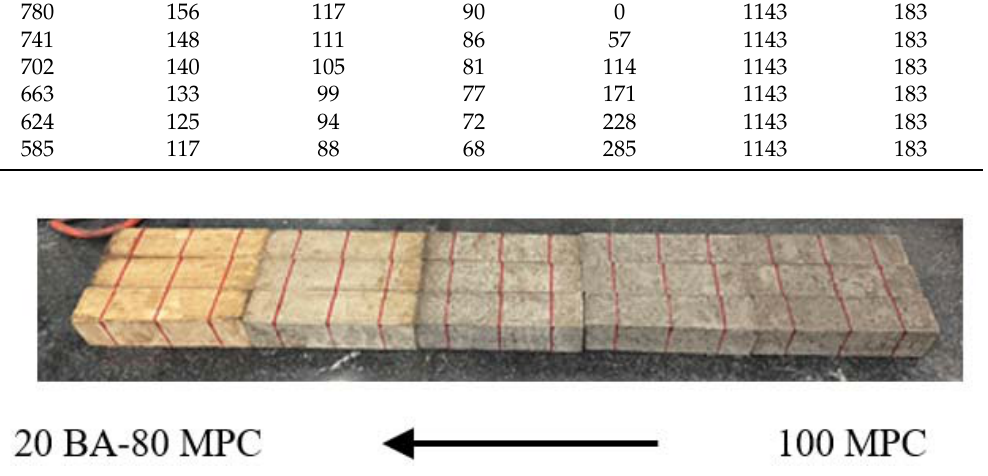
Table 2. Mix design of BA-MPC mortars composites (kg/m 3 ).